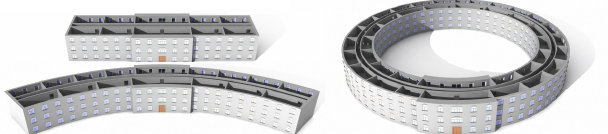
Figure 2: Deformation aware shape grammars allow the integra- tion of free-form deformation into a grammar-based system based on planar primitives and splits. An undeformed building with rooms (top image) is deformed using two different deformations (middle,